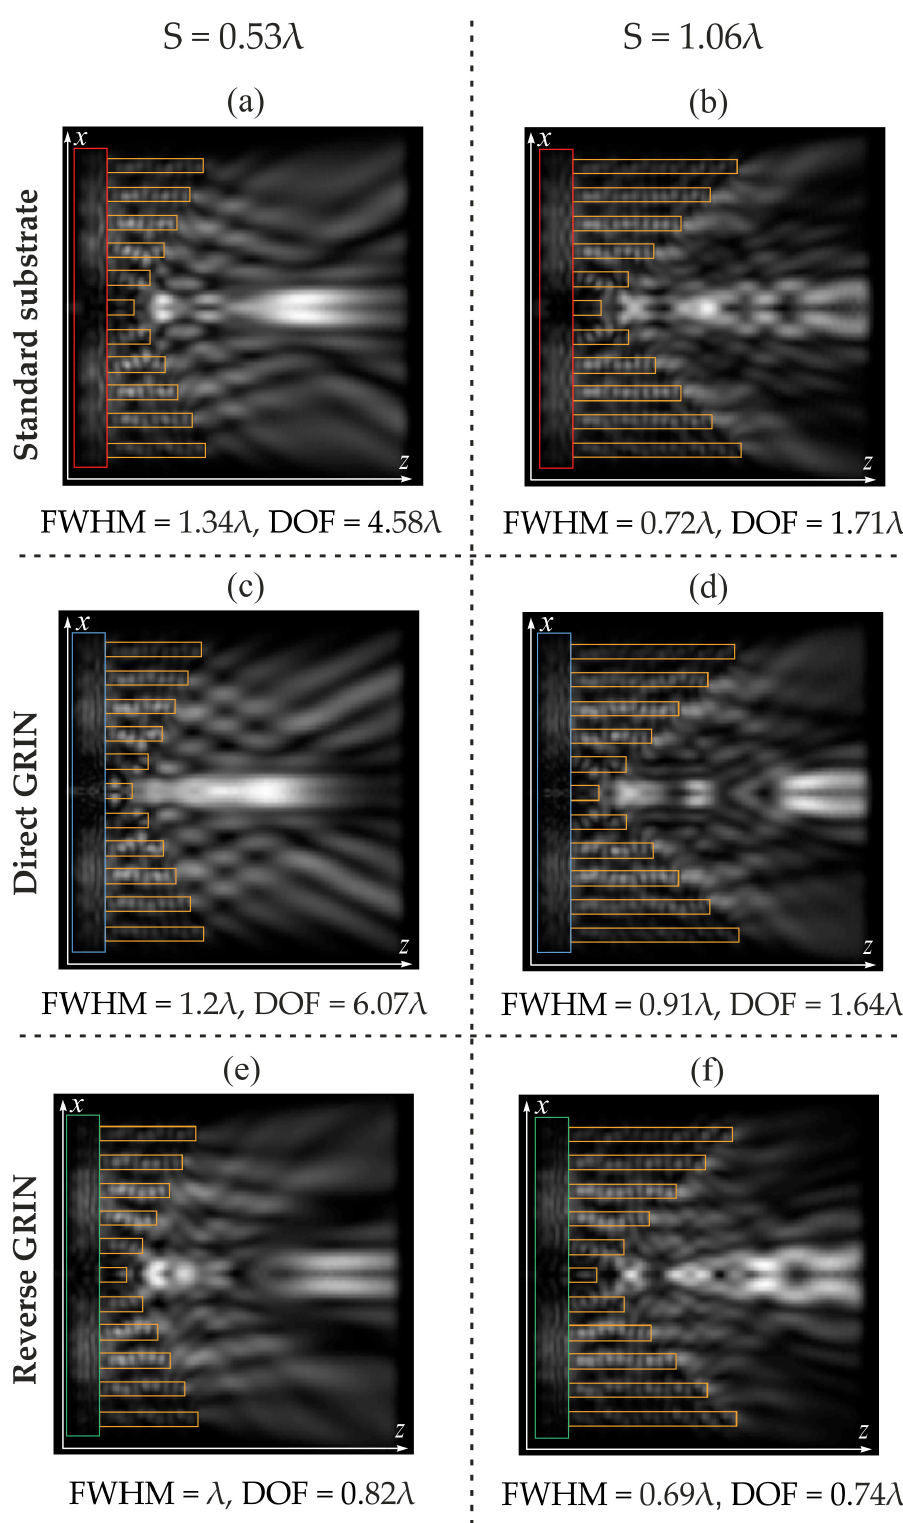
Figure 9. Two-dimensional diffraction pattern (intensity, xz plane) of the laser light propagation through reverse annular gratings with different steps S for ( a , b ) a standard substrate; ( c , d ) a direct GRIN substrate; and ( e , f ) a reverse GRIN substrate.